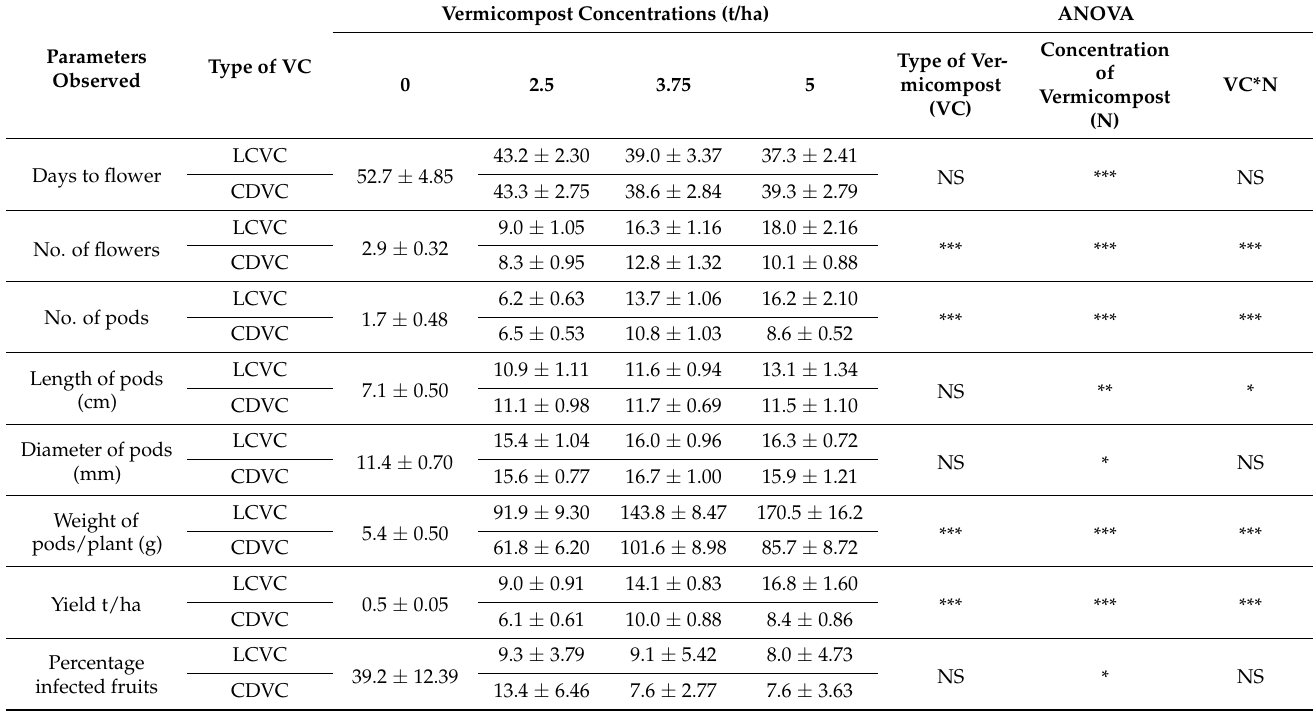
Table 2. Flowering and yield of A. esculentus plants grown in soil fertilized with different levels of lantana and cowdung vermicomposts. The numbers which do not differ significantly from controls ( p < 0.05) carry an asterisk. Single, double, and triple stars indicate the significance levels at p < 0.5, <0.01 and <0.001,